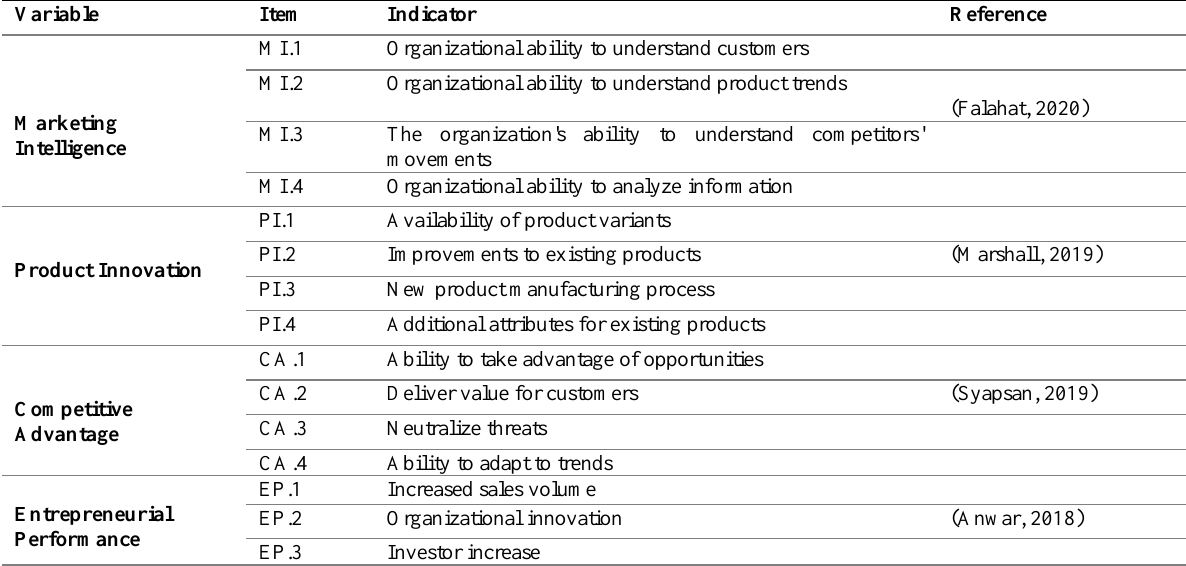
Table 2: Variable